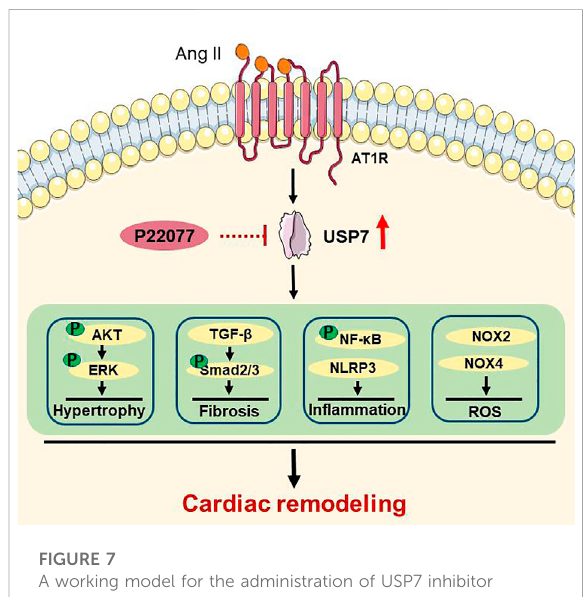
FIGURE 7 A working model for the administration of USP7 inhibitor p22077 to suppress cardiac remodeling in Ang II-induced hypertensive mice. Hypertension induces the expression of USP7. Blocking USP7 activity by p22077 inhibits multiple signaling pathways, which involved in hypertrophy, fi brosis, in fl ammation, and oxidative stress, thereby attenuates cardiac remodeling in Ang II-induced hypertensive